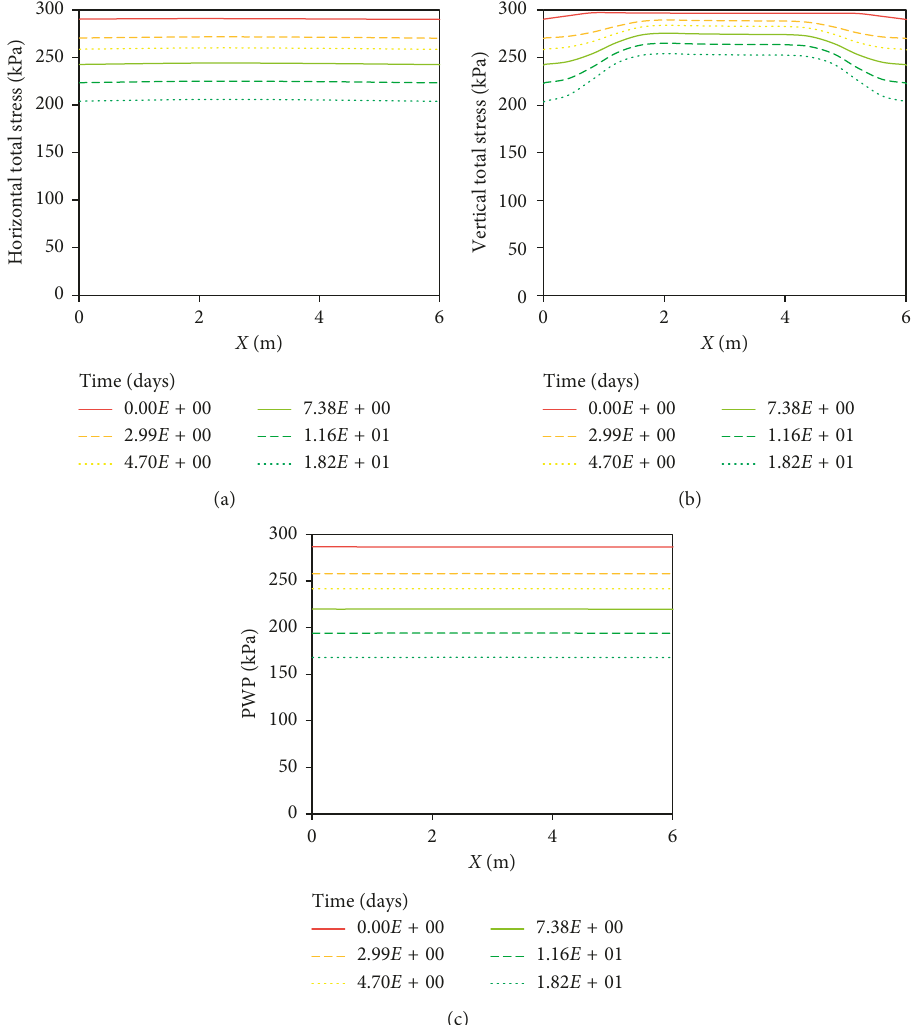
Figure 6: Evolution of the (a) horizontal ( σ h ) and (b) vertical ( σ v ) total stresses and (c) PWP ( u w ) along horizontal profile HP1 at midheight of the stope after addition of the last (150 th ) backfill layer for the reference case (see the details in Table 1, Case